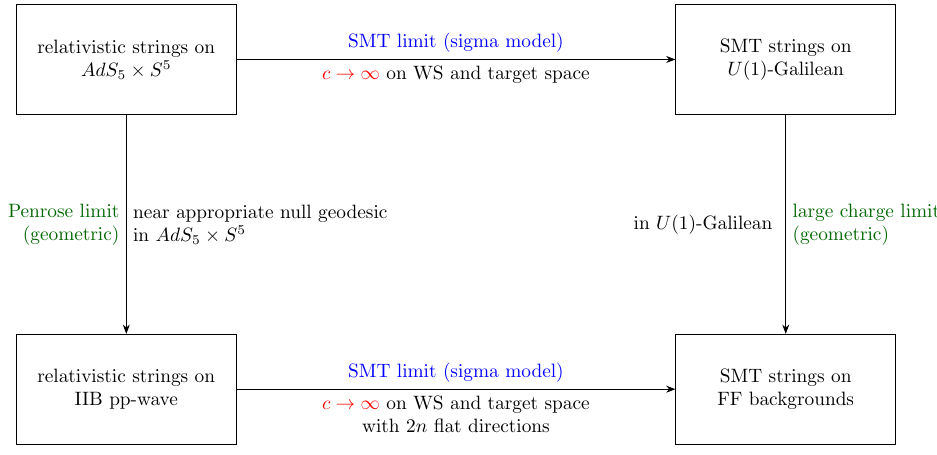
Figure 1 . Overview of SMT and large charge/Penrose